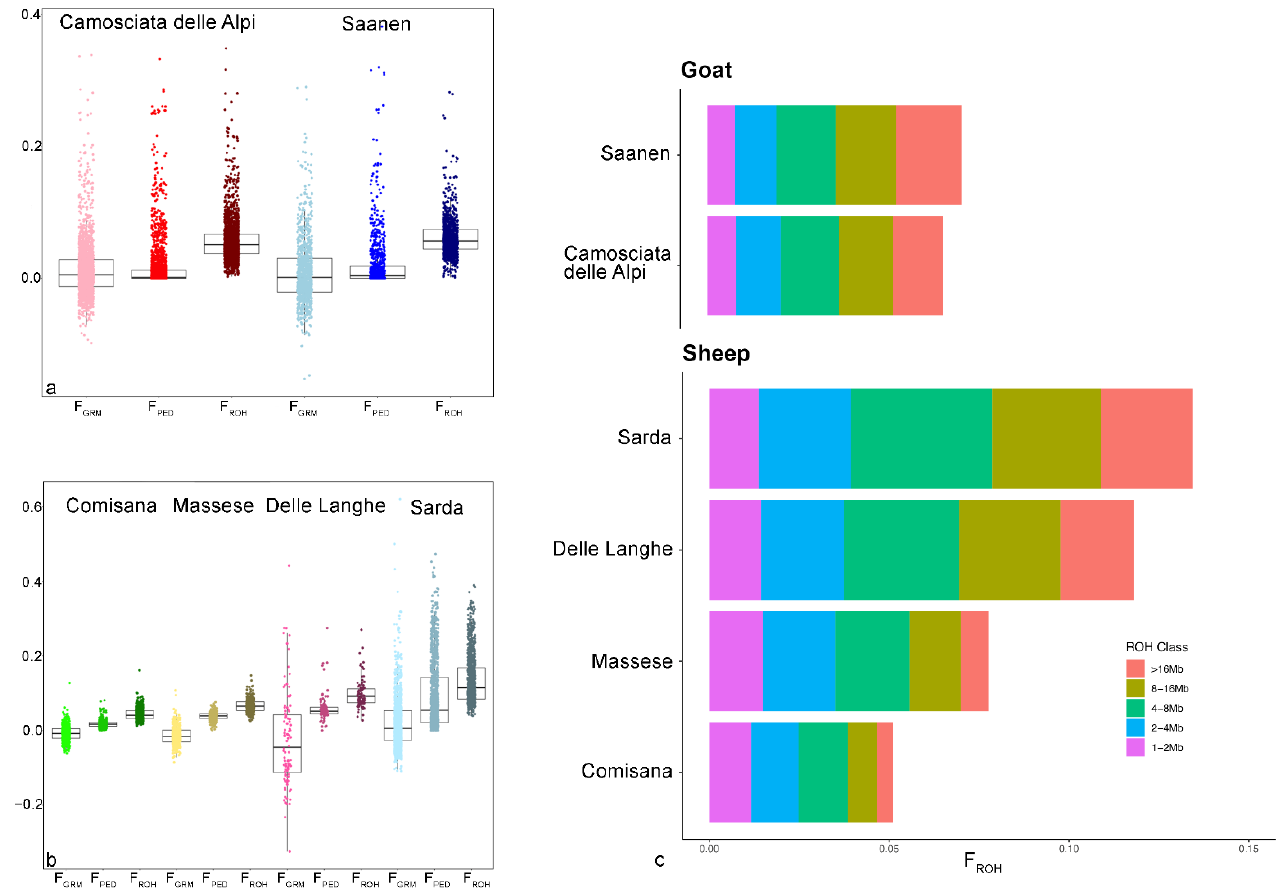
Figure 1. Distribution of F GRM , F PED and F ROH in goat ( a ) and sheep ( b ) breeds, and F ROH per ROH length class in the examined breeds ( c ).